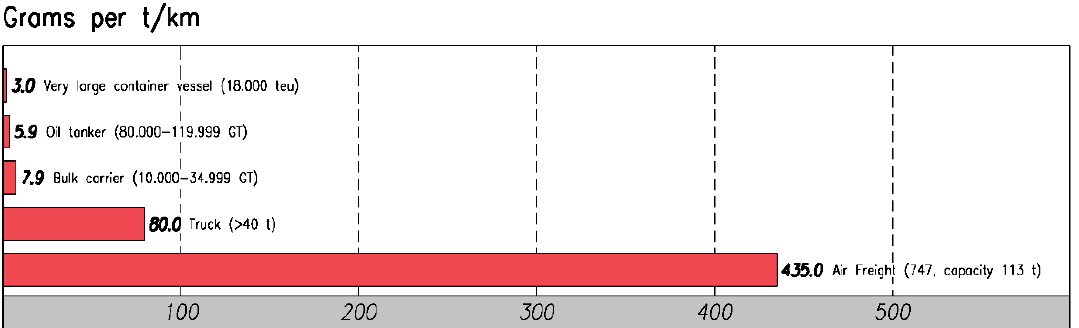
Figure 2. Comparison of typical CO 2 emissions among goods transportation options.